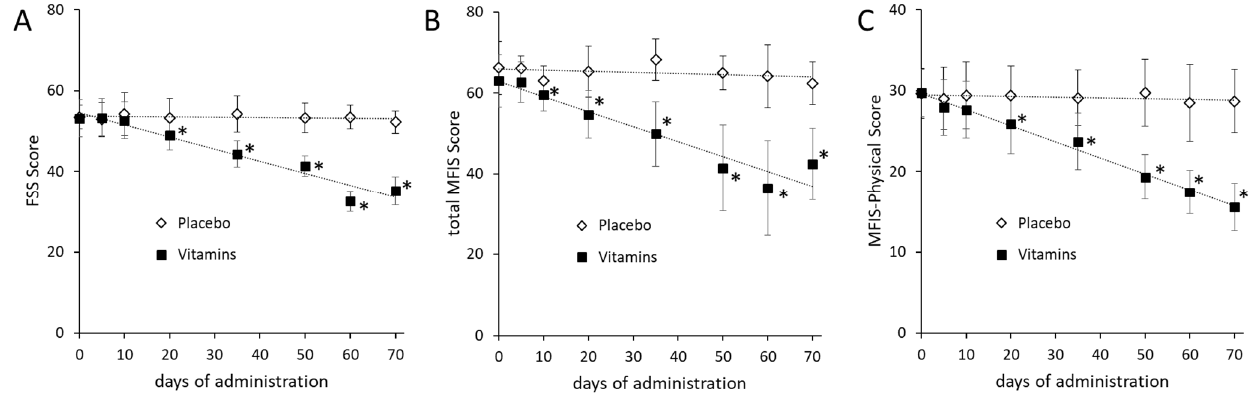
Figure 1. Changes in FSS ( A ), MFIS ( B ), and Physical Subscale ( C ) values in placebo and supplemented groups of MS affected subjects. The tendency curve is indicated by the dotted line. The data are expressed as mean ± SD. The p -values were calculated using the Mann–Whitney U test and considered significant when p < 0.01. Asterisks indicated perceived fatigue conditions significantly differing between supplemented and placebo groups.